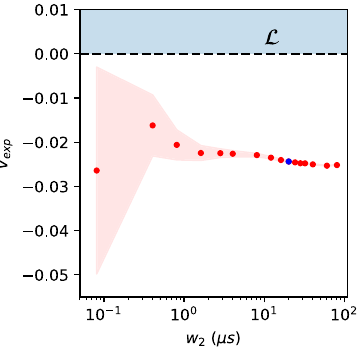
Fig. 6 | In fl ation inequality violation versus 6-fold coincidence window. Values of violation of the causal compatibility inequality, which has been optimized over the experimental data corresponding to the blue point (a window w 2 ~20 μ s), as a function of the 6-fold coincidence window w 2 . The red shadowed area represents the statistical error on the computed value of V exp , estimated employing Monte Carlo methods. The blue shadowed region L indicates the values obtainable by a classical causal